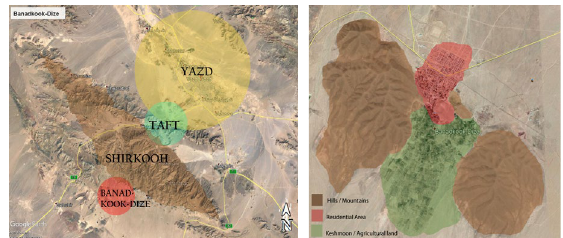
Figure 1. From left; location of the village, natural and synthetic effects in the village, author.